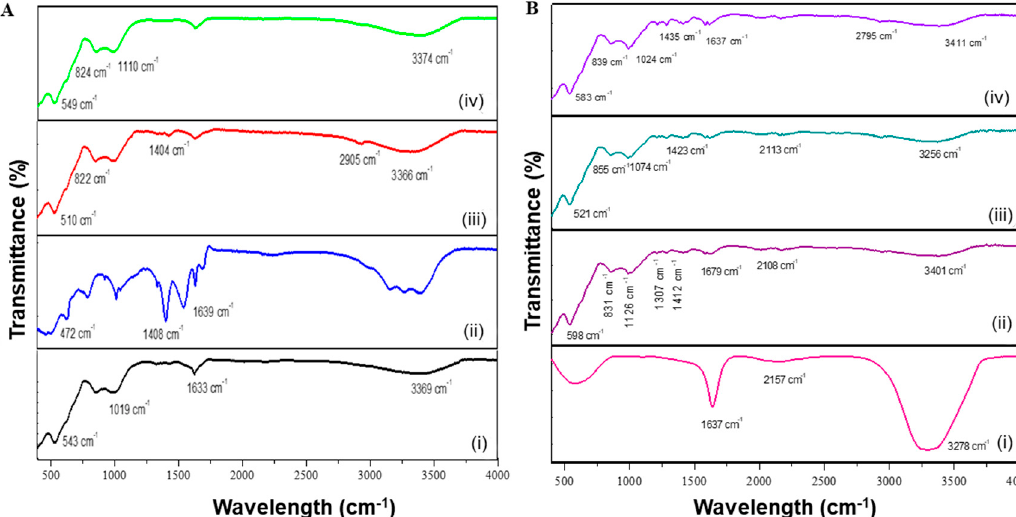
Figure 1. FTIR spectra for ( A ) MNPs and ( B ) DOX-loaded MNPs. A : ( i ) MgFe 2 O 4 , ( ii ) CHI- MgFe 2 O 4 , ( iii ) PVA- MgFe 2 O 4 and ( iv ) PEG- MgFe 2 O 4 .; and B : ( i ) DOX, ( ii ) DOX-CHI-MgFe 2 O 4 , ( iii ) DOX- PVA-MgFe 2 O 4 and ( iv ) DOX- PEG-MgFe 2 O 4.